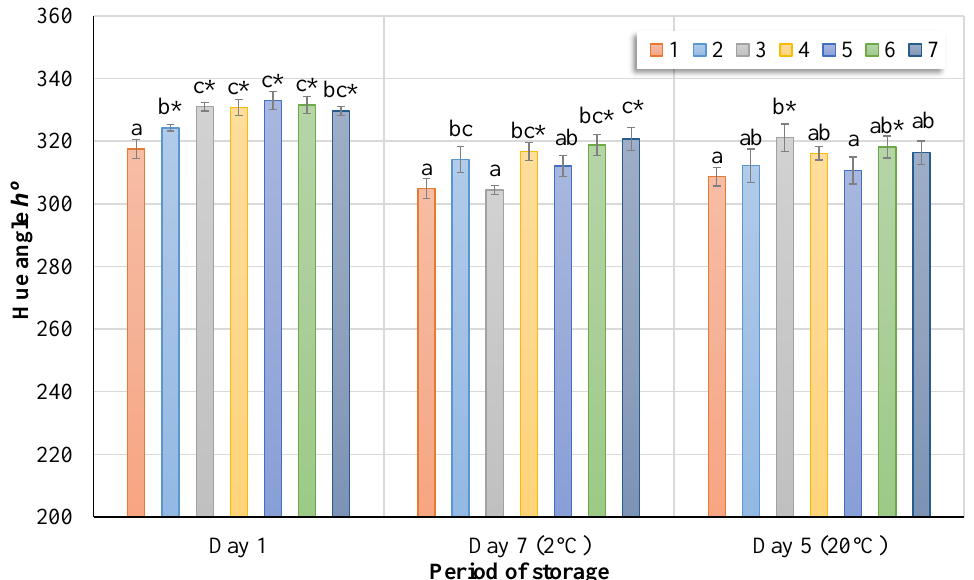
Figure 7. Changes in the hue angle of birch sap h ° during storage: 1 (control) — untreated sap (initial); 2 — sap ozonated for 5 min; 3 — sap ozonated for 10 min; 4 — sap ozonated for 15 min; 5 — sap ozonated for 20 min; 6 — sap ozonated for 25 min; 7 — sap ozonated for 30 min. Dunnett tests treat one group as the control (No. 1) and compare all other groups against it. A significant difference between the control group and the other treatment groups is denoted by an asterisk “*” . Tukey HSD test was used for the comparison of processing methods (marked in lowercase letters). The mean difference is significant at the 0.05 level ( n = 18).